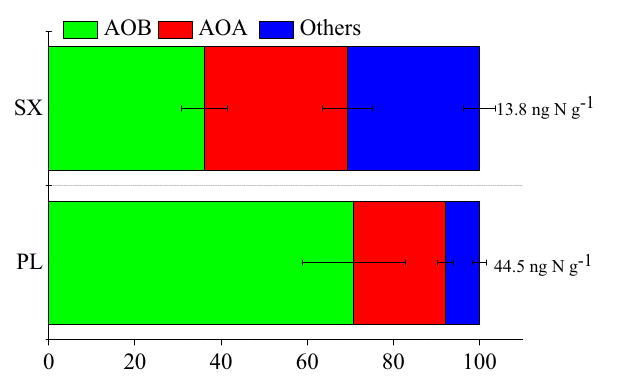
Figure 4. The relative contributions to N 2 O production of AOA and AOB from two soils with ammonia amendment treatments after 21 days incubation. Error bars represent standard errors of three biological